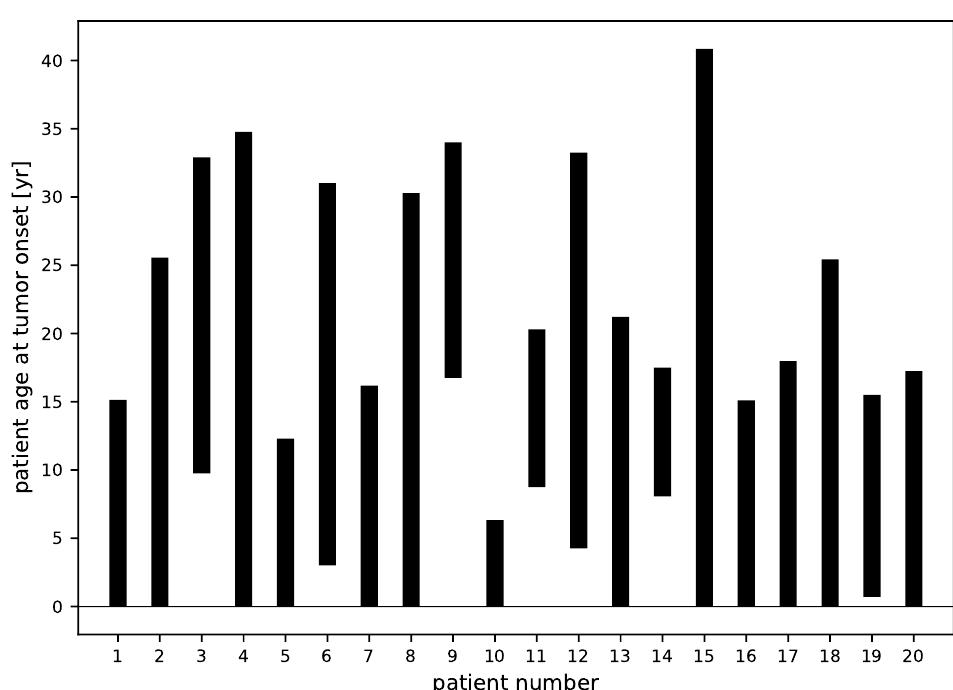
Figure 5. The 95% confidence level intervals of the ages of the patients at the onset of the tumors determined from the profile-likelihood